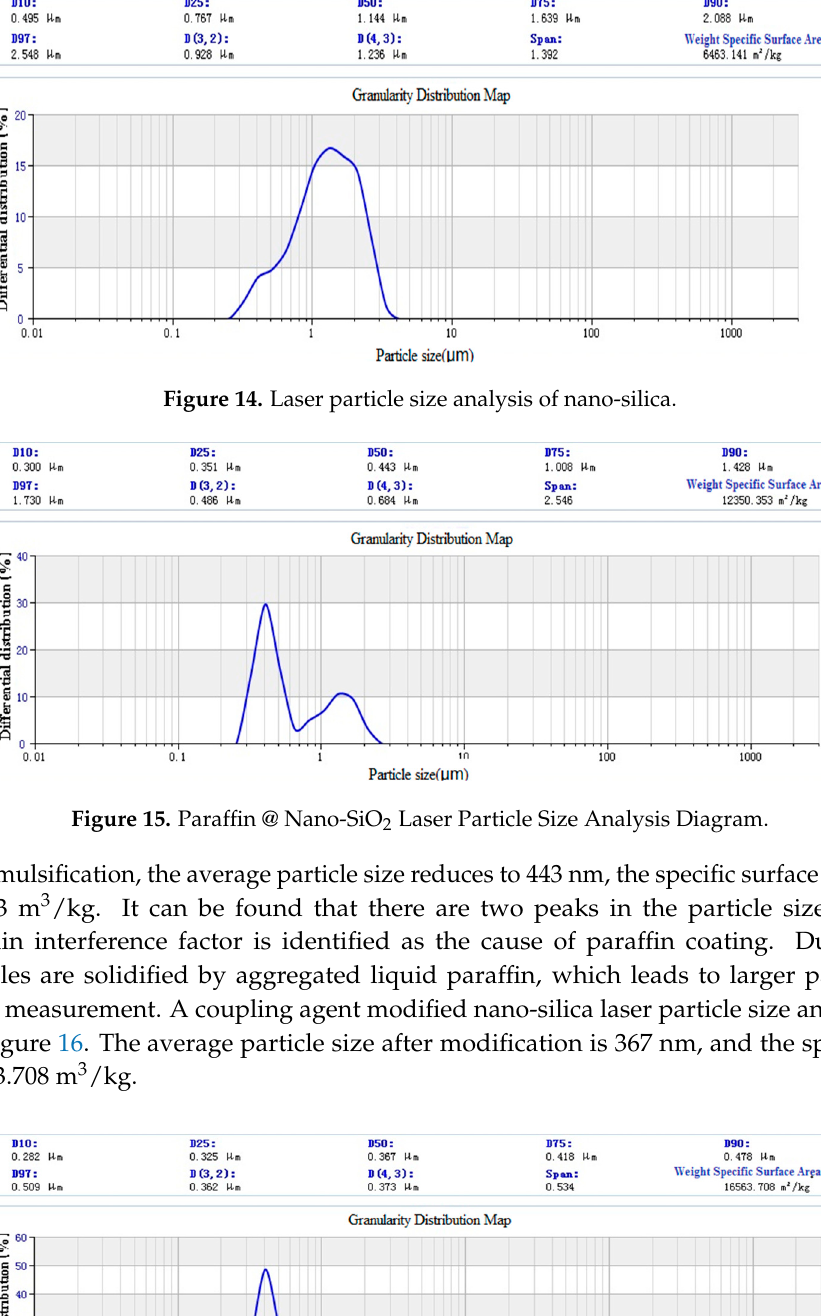
Figure 16. Laser particle size analysis of nano-silica modified by coupling agent.